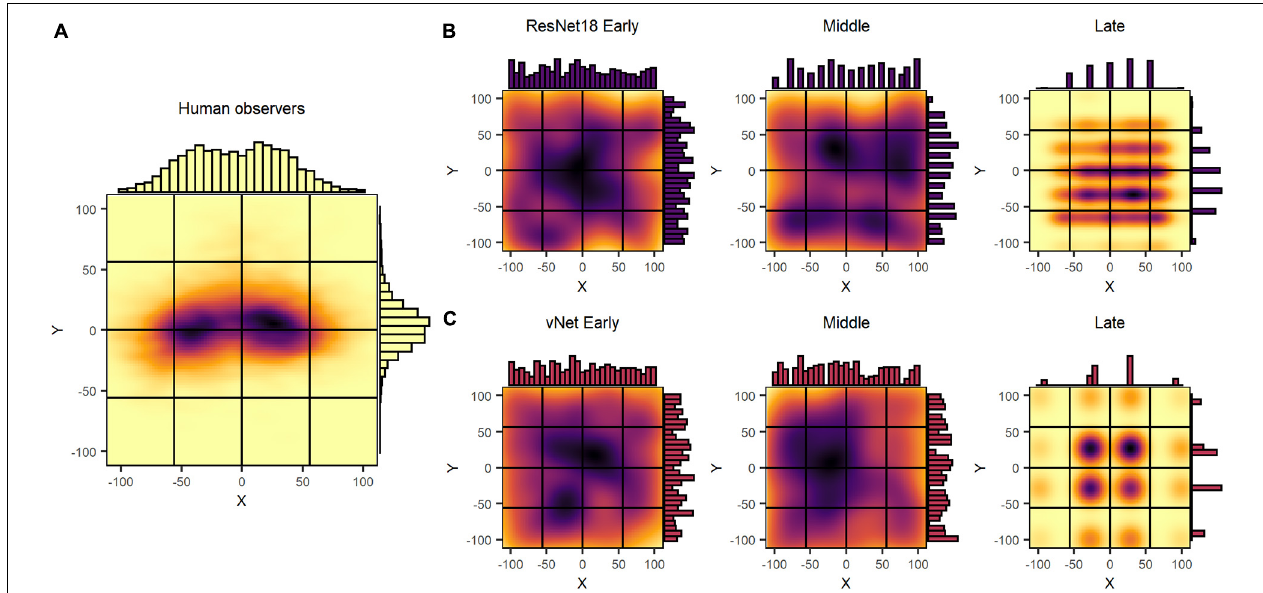
FIGURE 6 | Uncorrected spatial priorities during feedforward object recognition in human observers and DCNNs. (A) Human fixations were affected by a central fixation and saccadic motor bias, while being normally distributed on a continuous scale. (B,C) ResNet18 and vNet GradCAM maxima displayed a near uniform distribution in early and middle layers with a 7 × 7 and 4 × 4 grid in the late layers. Generally, maxima followed a discrete segmentation that was identical to the output size of the respective